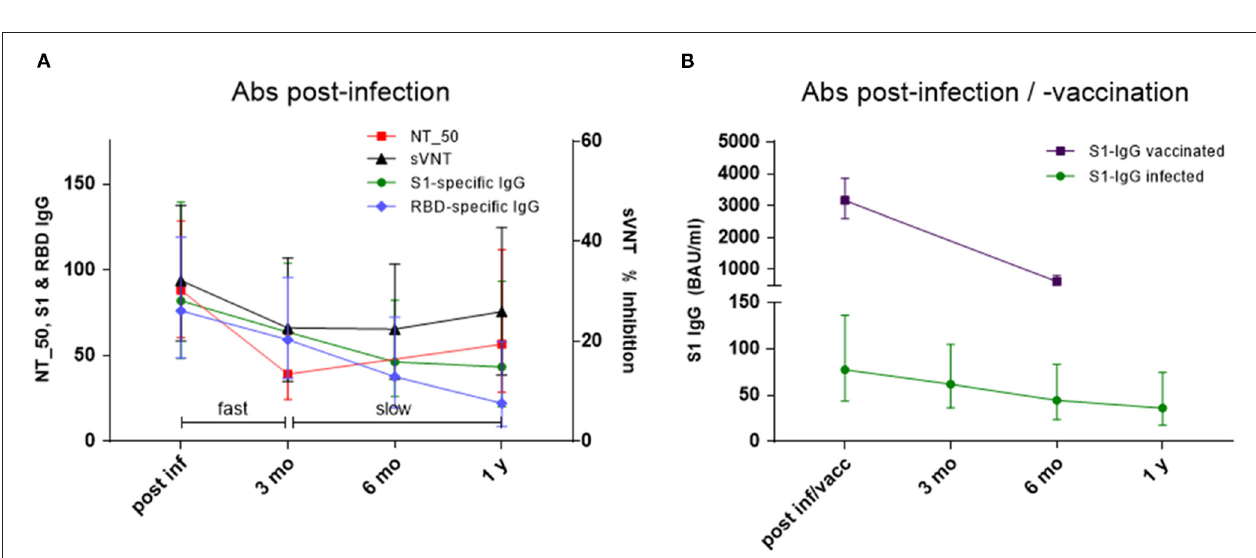
FIGURE 3 | (A,B) Decline kinetics for (A) NT_50 titers 1: x, % inhibition in sVNT, S1-specific IgG in BAU/ml and RBD-specific IgG in IU/ml post-infection and 3 months, 6 months and 1 year thereafter. Geometric mean titers & 95% CI of NT_50 titers, geometric means & 95% CI of S1-specific IgG, RBD-specific IgG, and % inhibition in sVNT; fast corresponds to ß 1 and slow to ß 2 in Eq. 1 (see text); and (B) S1-specific IgG in BAU/ml (geometric mean & 95% CI) in infected individuals and healthy controls vaccinated twice (4-week interval) with SARS-CoV-2 mRNA vaccine (post-infection/vaccination and after 6